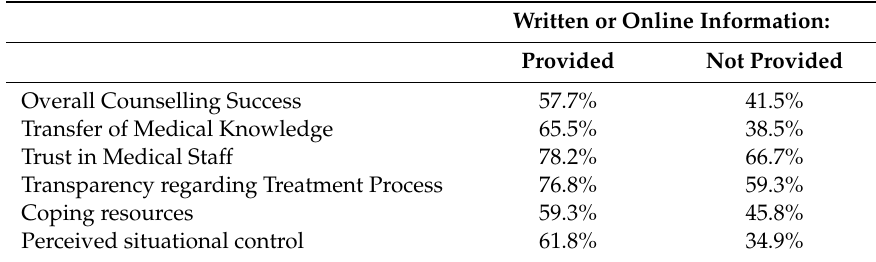
Table 3. Providing additional written information or links to online information sources leads to more overall counselling success and counselling success in all five created analytical dimensions.